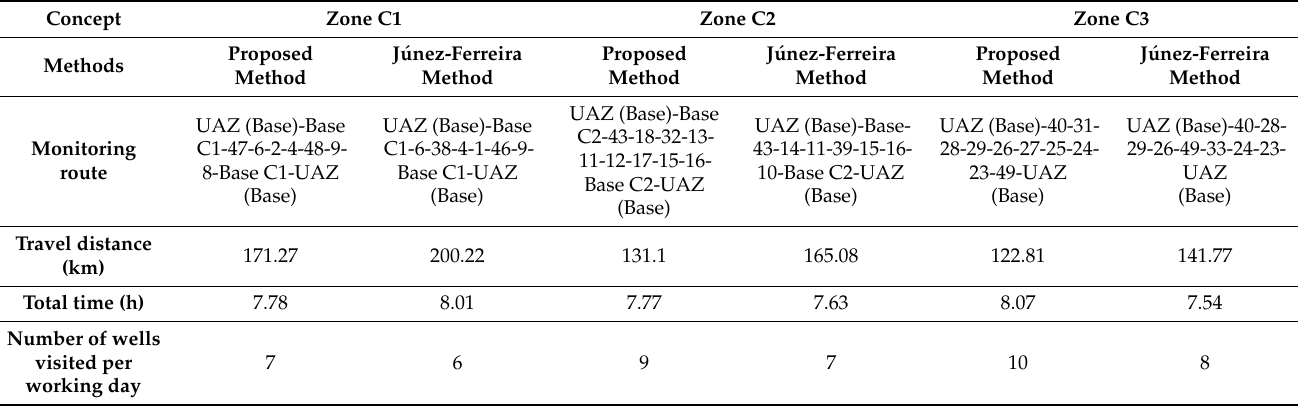
Figure 9. Routes and monitoring order of the wells selected when applying the Júnez-Ferreira method for zones C1 ( a ), C2 ( b ) and C3 ( c ). Table 2. Comparison between the different routes for the optimal Calera aquifer monitoring network, selected with the proposed and the J ú nez-Ferreira